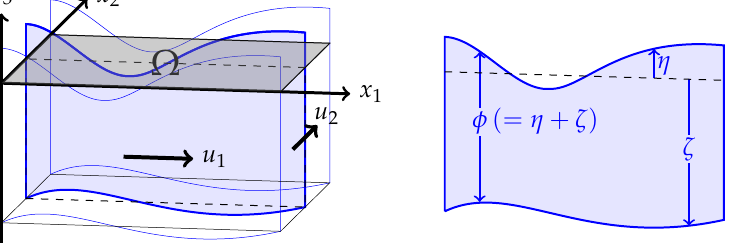
Figure 2. Diagrams for the problem; left: the domain Ω and the velocity u = ( u 1 , u 2 ) (cid:62) ; right: the total wave height φ = η + ζ